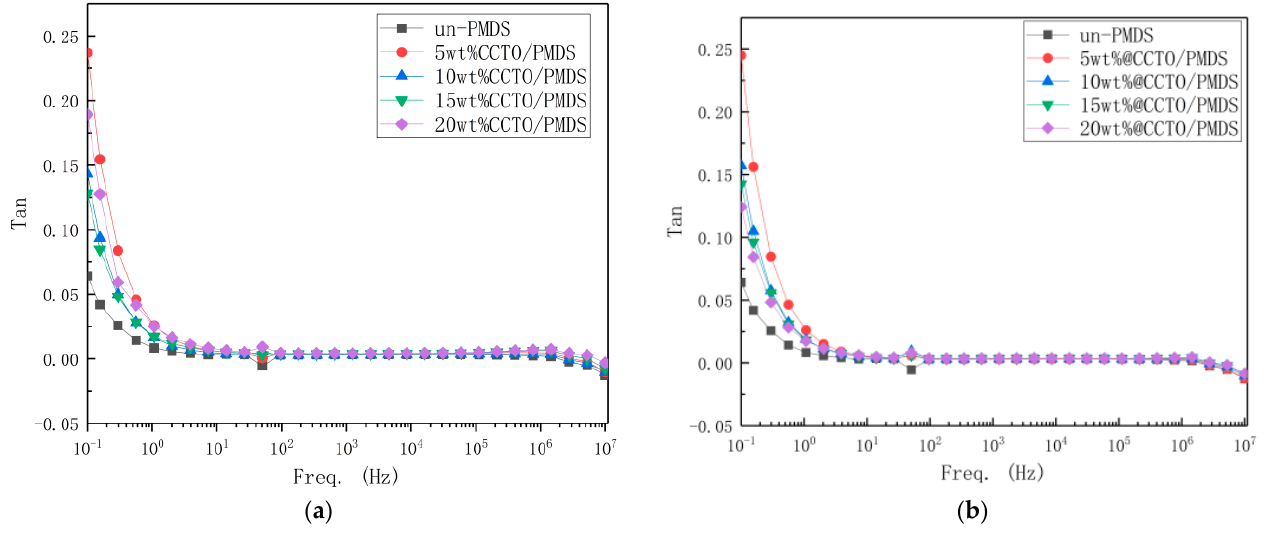
Figure 12. ( a ) The dielectric loss spectrum of CCTO/PDMS composite; ( b ) The dielectric loss spectrum of modified CCTO/PDMS composite.